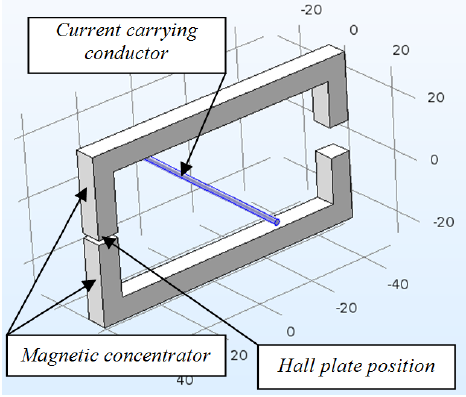
Figure 2. Construction with two air gaps.